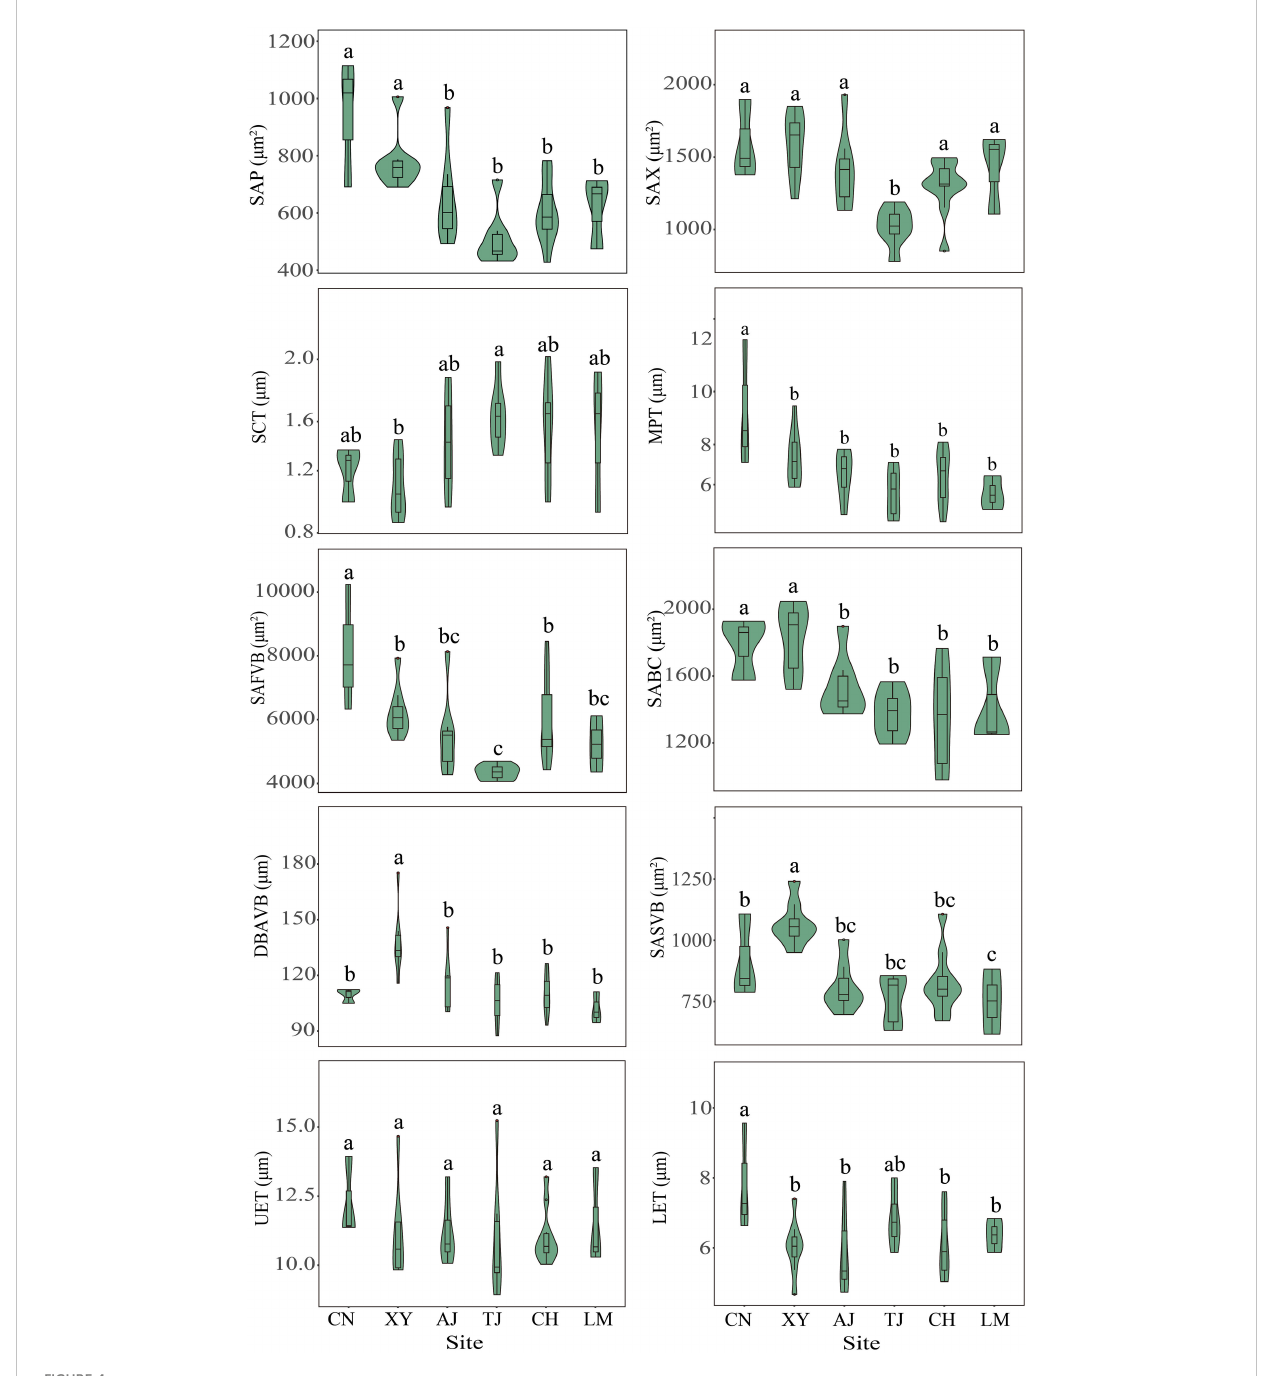
FIGURE 4 Leaf anatomical traits of moso bamboo forests in different sites. AJ, Anji; CH, Conghua; CN, Changning; LM, Longmen; TJ, Taojiang; XY, Xinyang. Different letters indicate signi fi cant differences among sites at the 0.05